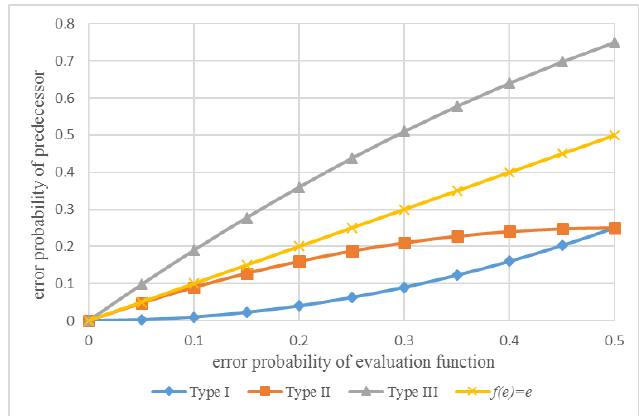
Figure 4. Trends of the error probability during